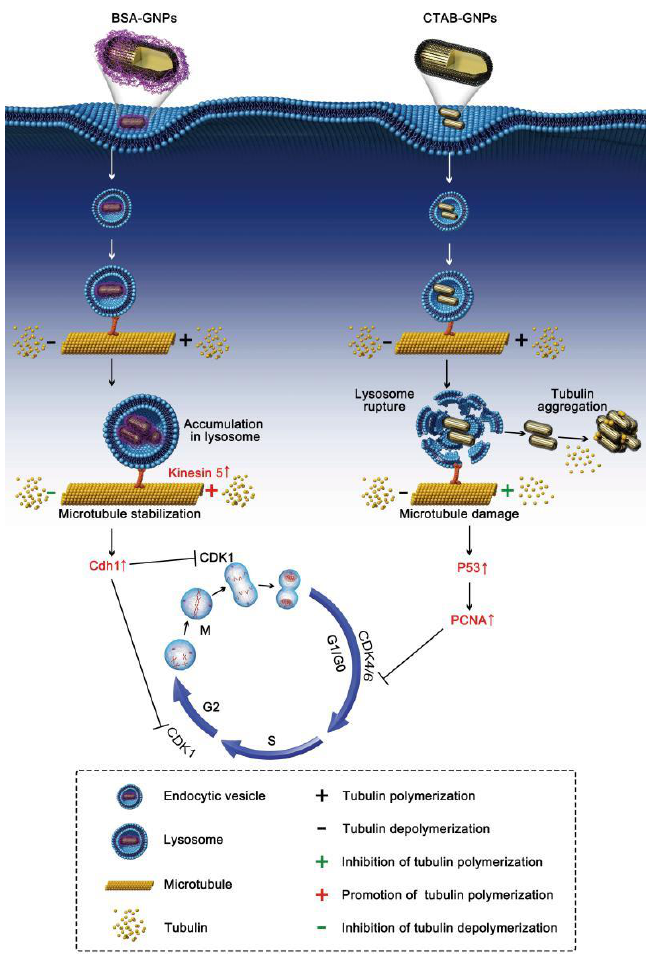
Figure 5. Mechanism through which GNPs causes cell cycle arrest was dependent on the biocompatible property of GNP surface. Coating of GNPs with biocompatible molecules, such as BSA, inhibited lysosome rupture and switched G 0 /G 1 arrest to G 2 /M arrest. The accumulation of BSA-GNPs in lysosomes increased the level of kinesin 5A and caused subsequent stabilization of microtubules (including promotion of tubulin polymerization and inhibition of tubulin depolymerization), blockage of chromosome segregation, and induction of cell cycle arrest in G 2 /M via Cdh1 elevation. In contrast, toxic CTAB on the surface of GNPs caused lysosome rupture and ssubsequent microtubule damage through tubulin aggregation. These changes induced G 0 /G 1 arrest through regulation of p53 and